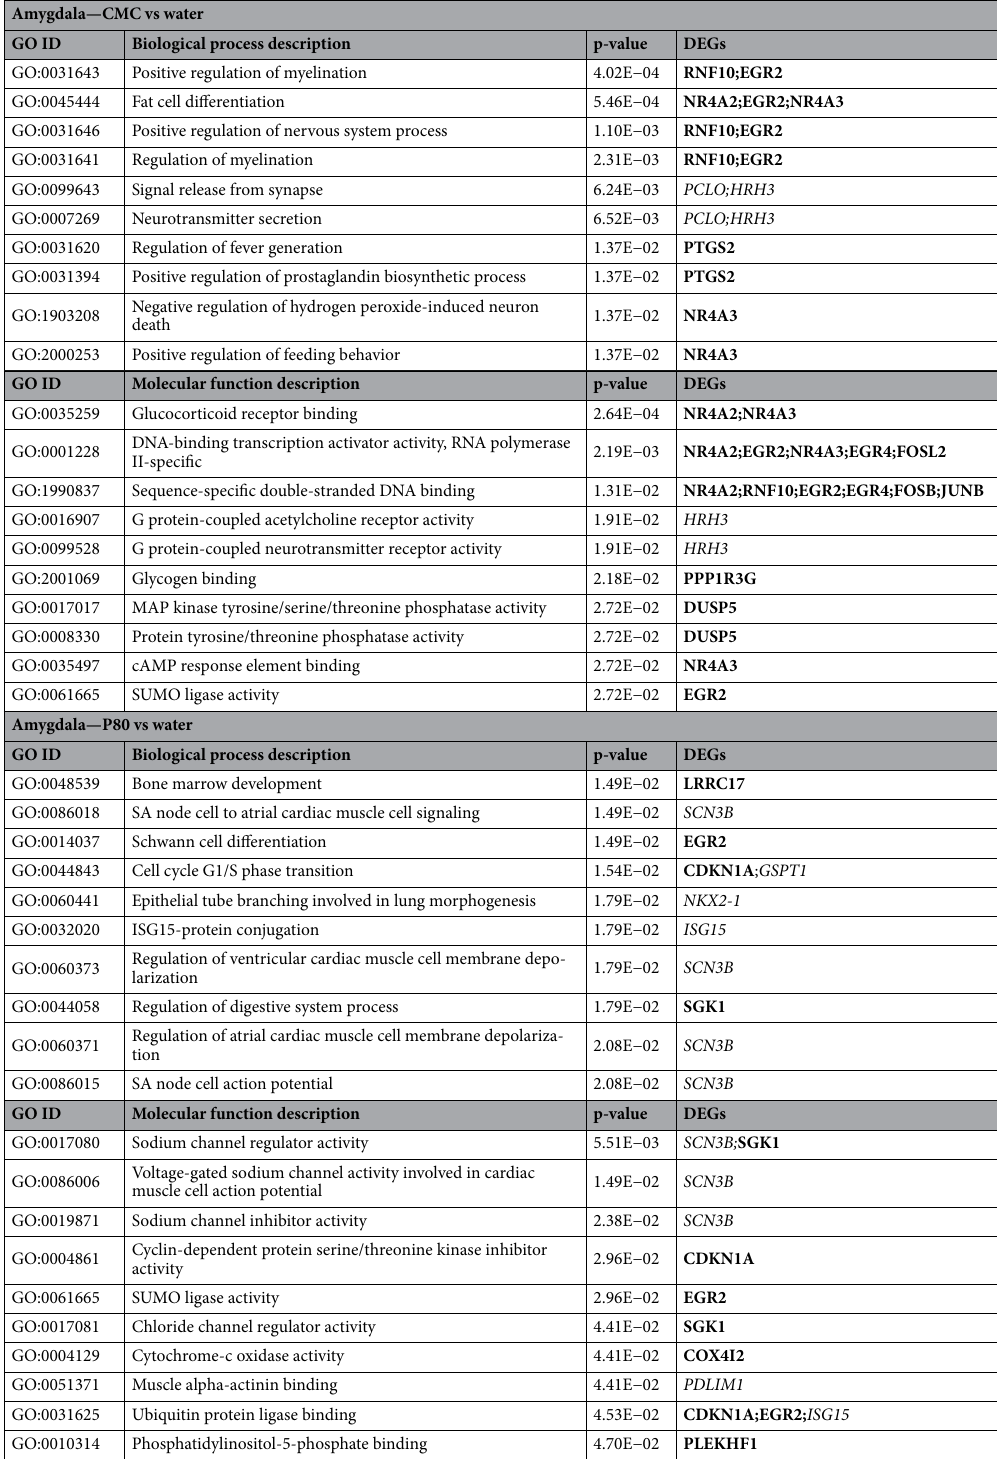
Table 1. Gene ontology of differentially expressed genes in the amygdala of emulsifier treated mice. Using EnrichR, differentially regulated gene lists were evaluated for significant enrichment against the following gene set libraries: GO Biological Process, GO Molecular Function (all from http:// www. geneo ntolo gy. org). The top 10 enriched terms were selected and ranked based upon the combined score that was calculated by the EnrichR platform following Z-score permutation background correction on the Fisher exact test p-value. Results were filtered for p < 0.05. Upregulated genes in bold and downregulated genes in